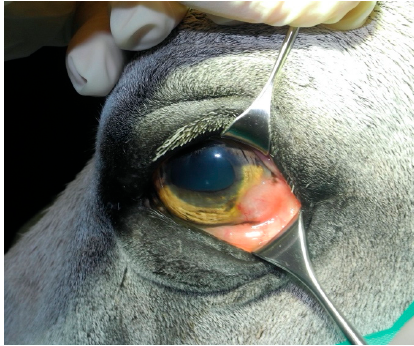
Figure 3. Clinical photograph of a Connemara Pony (Case 3) depicting the pink, raised mass on the left temporal limbus and cornea.